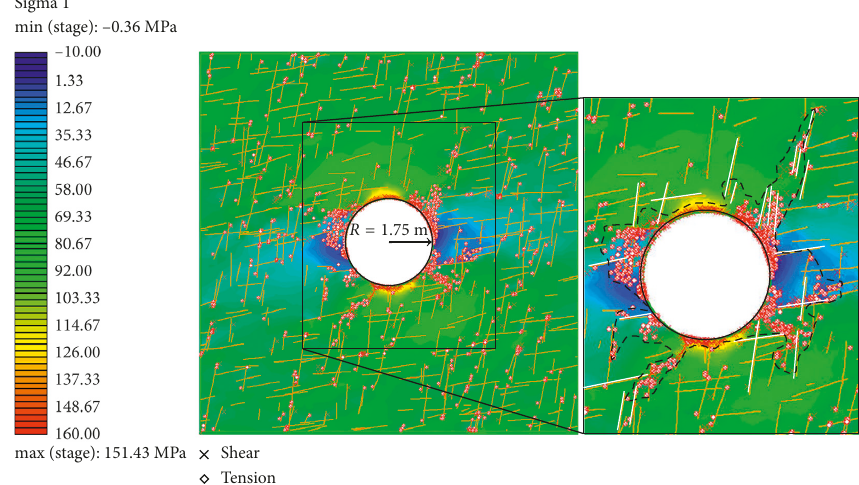
Figure 14: Major principal stress σ 1 contours of the fractured FEM model using the Hoek–Brown criterion (GSI (cid:31) 80). Yielded elements in shear ( ) and in tension ( ) are plotted. The dashed black line indicates the damage profile based on the recorded yielded elements. White × lines indicate the contributing joints to the obtained damage profile. ○